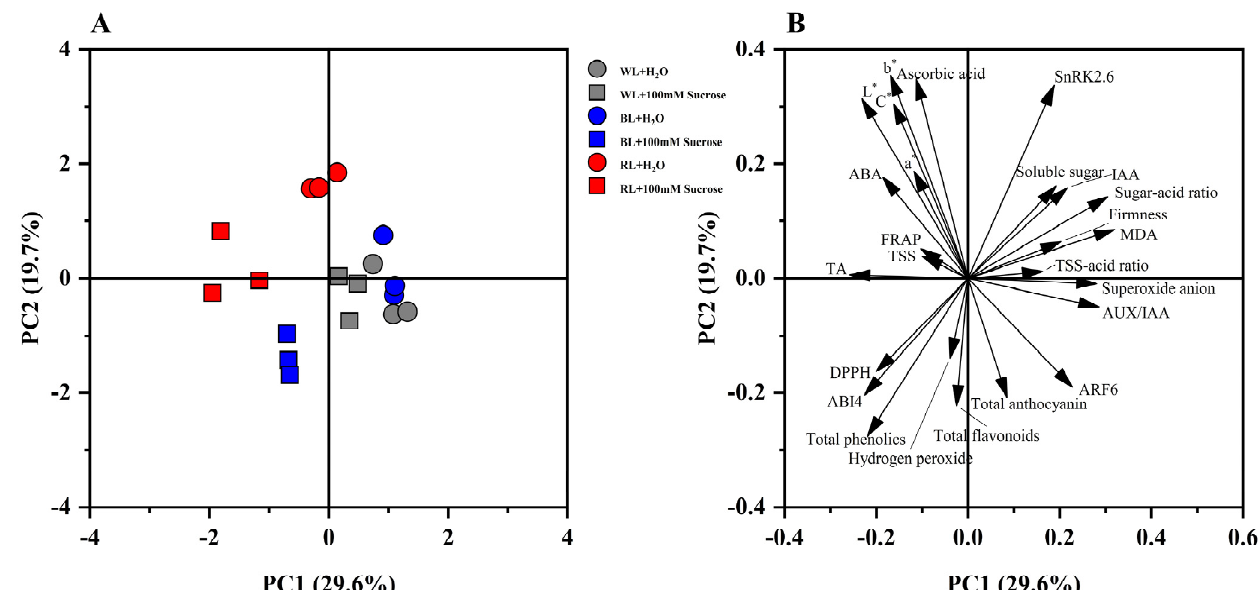
Figure 6. PCA analysis. ( A ) PCA score plot; ( B ) PCA loading plot.